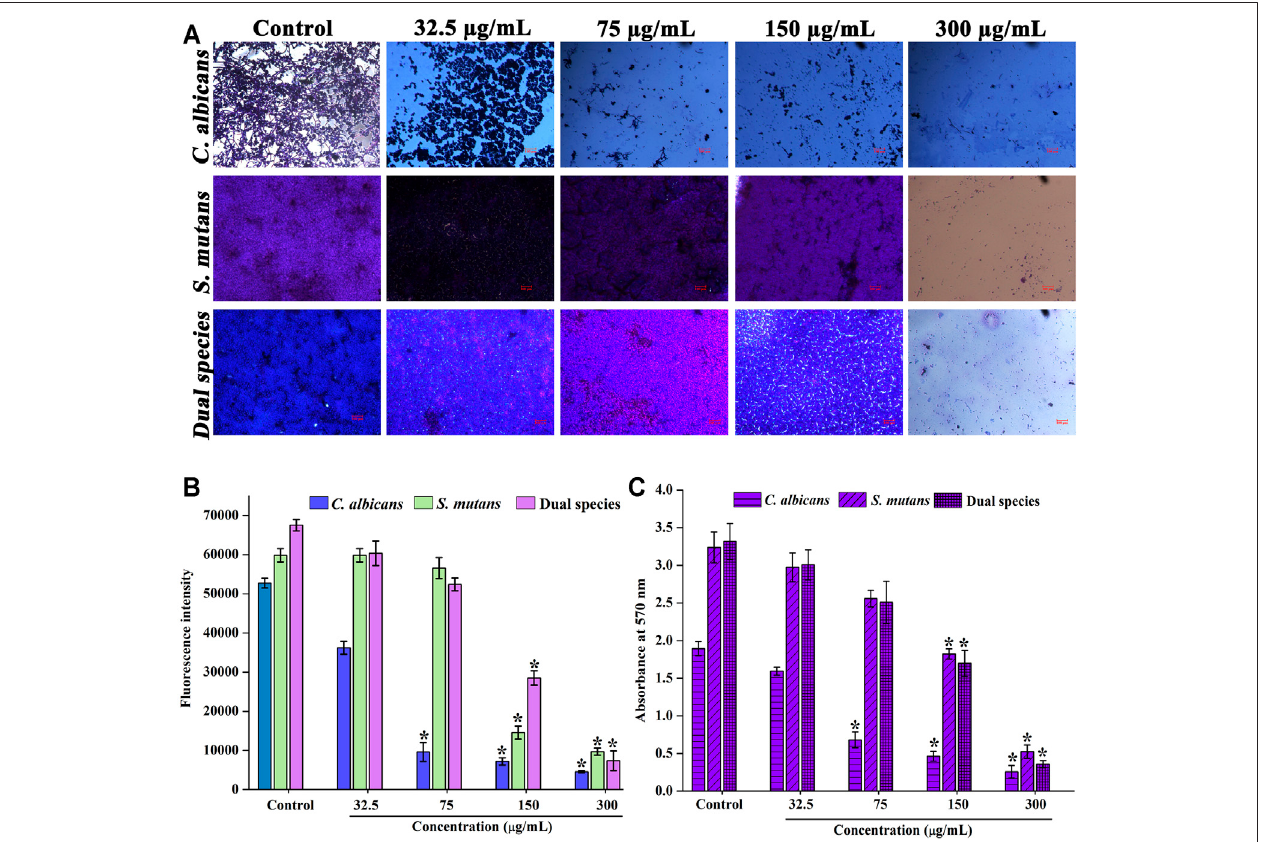
FIGURE2| Effectofthymolonthebio fi lmofsingleanddualspeciesof C.albicans and S.mutans. Concentration-dependentbio fi lminhibitoryeffectofthymol (A) as visualized through a microscope (B) Alamar blue assay (C) bio fi lm inhibitory effect of thymol in the presence of saliva. Error bars represent standard deviations from the mean and * indicates signi fi cance p <